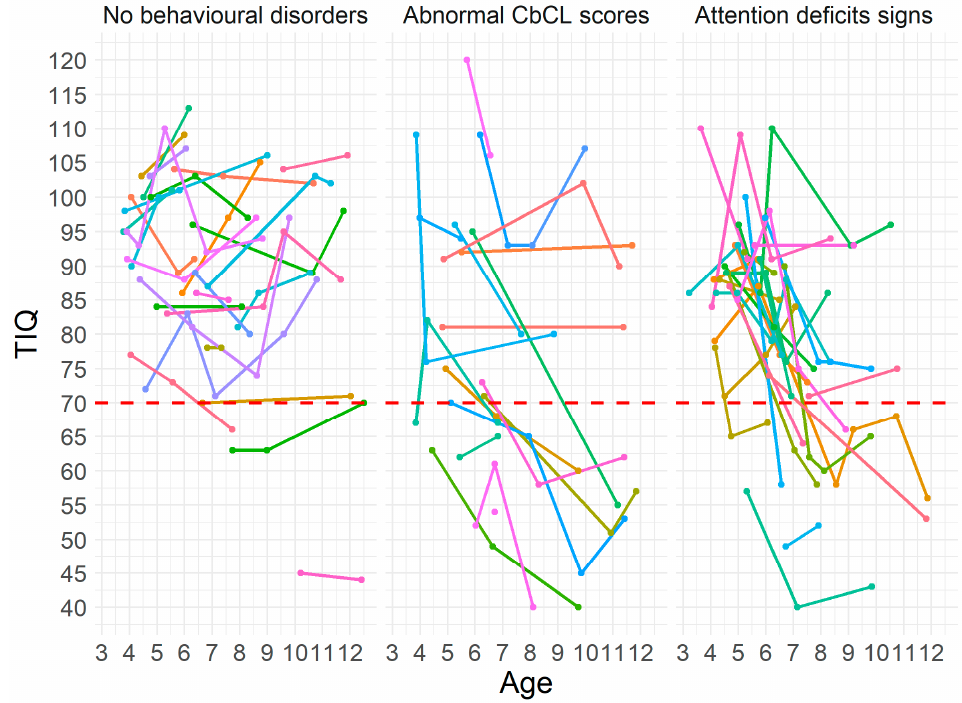
Figure 1. Individual IQ changes in patients with no behavioral disorders, with abnormal CBCL, and in those with attention deficits. Key to figure: dashed red line TIQ = 70, each colored line represent an individual patient.